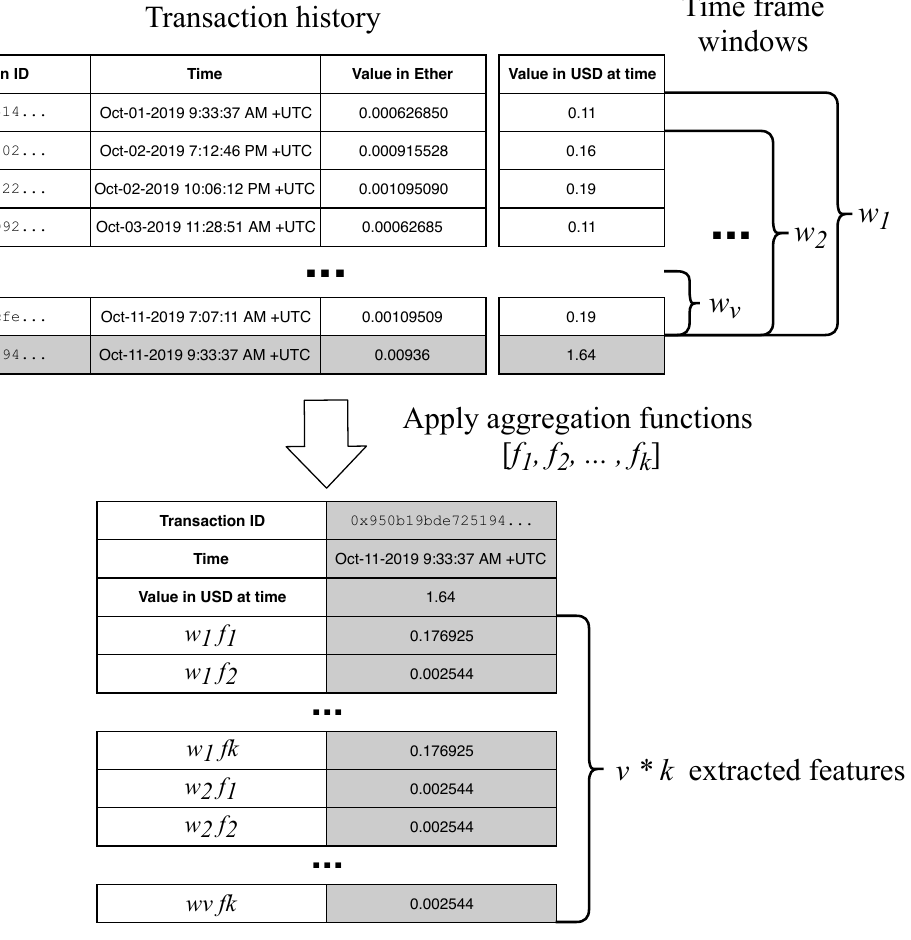
Figure 2. Current transaction processing